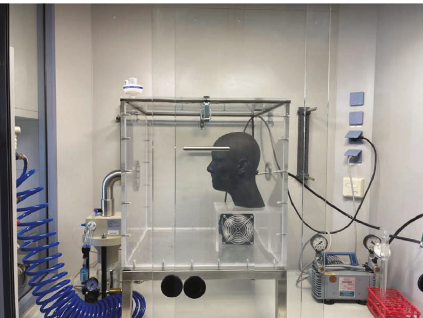
Figure 3: Distribution of as-worn bioaerosol protection against infective MS2-containing